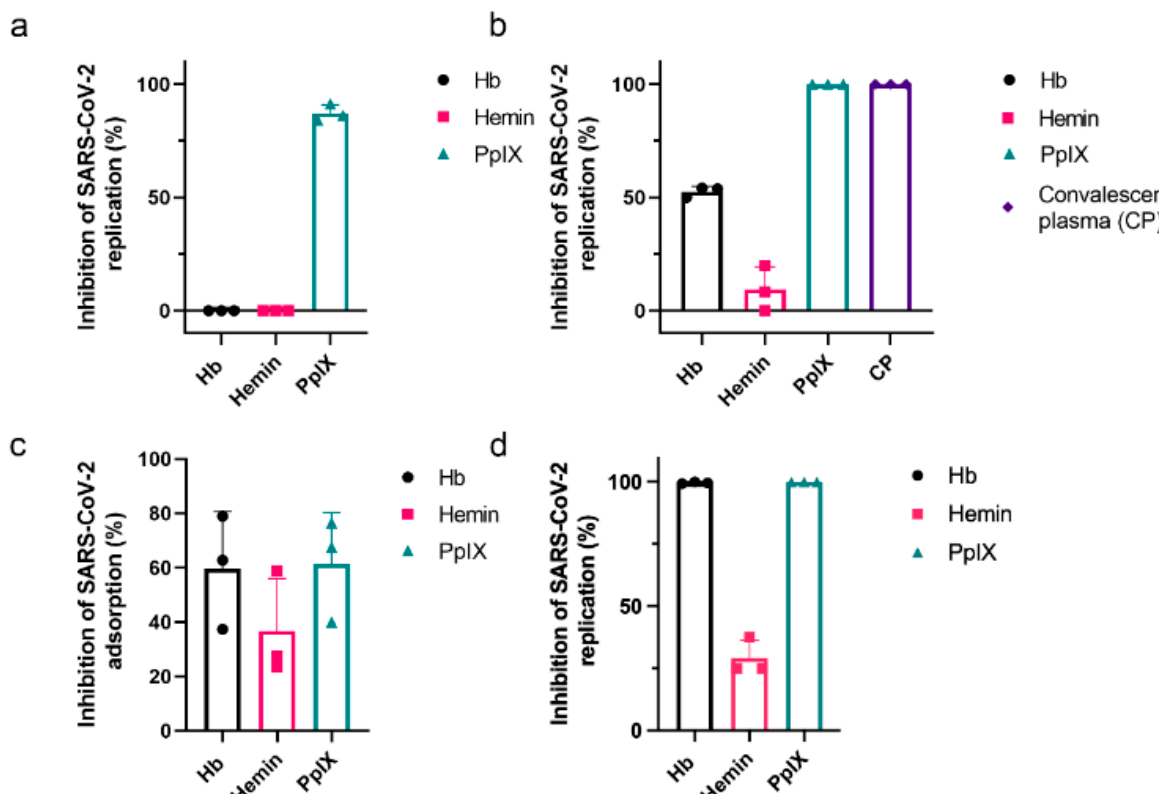
Figure 5. Inhibition of SARS-CoV-2 replication and attachment by porphyrins and Hb. Vero E6 cells ( a ) or SARS-CoV-2 ( b ) were pre-incubated with 1 µ M of Hb, hemin, or PpIX for 1 h at 37 ◦ C before the start of infection with an MOI of 0.01 for an additional hour at 37 ◦ C. Culture supernatants were collected after 24 h, and the virus titer was determined by plaque assay ( n = 3). A convalescent plasma of an infected patient (1:3 dilution) was used as the positive control. ( c ) SARS-CoV-2 was incubated at 1 µ M Hb, hemin, or PpIX for 1 h at 37 ◦ C before introducing Vero E6 cells at an MOI of 0.01 for 1 h at 4 ◦ C. Rinsed cell monolayers were lysed, and RT-PCR quantified the virus content. Cumulative data (Hb, Hemin, PpIX: n = 3). ( d ) Vero E6 was infected with SARS-CoV-2 at an MOI of 0.01 for 1 h at 37 ◦ C and then treated with 1 mM of hemin, PpIX, or Hb. After 24 h, supernatants were collected, and the virus titer was quantified by PFU/mL (Hb, Hemin, PpIX: n = 3). Data represented the percentage of inhibition compared to control (infected and untreated) and expressed as mean with standard deviation. Source data are provided as a Source Data